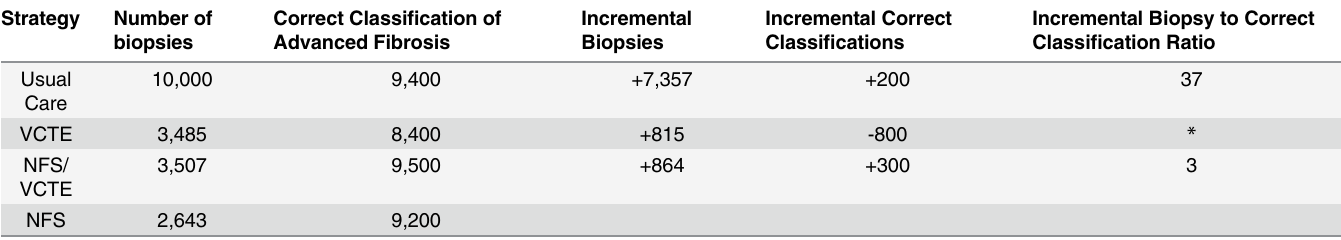
Table 3. Strategy Performance in a cohort of 10,000